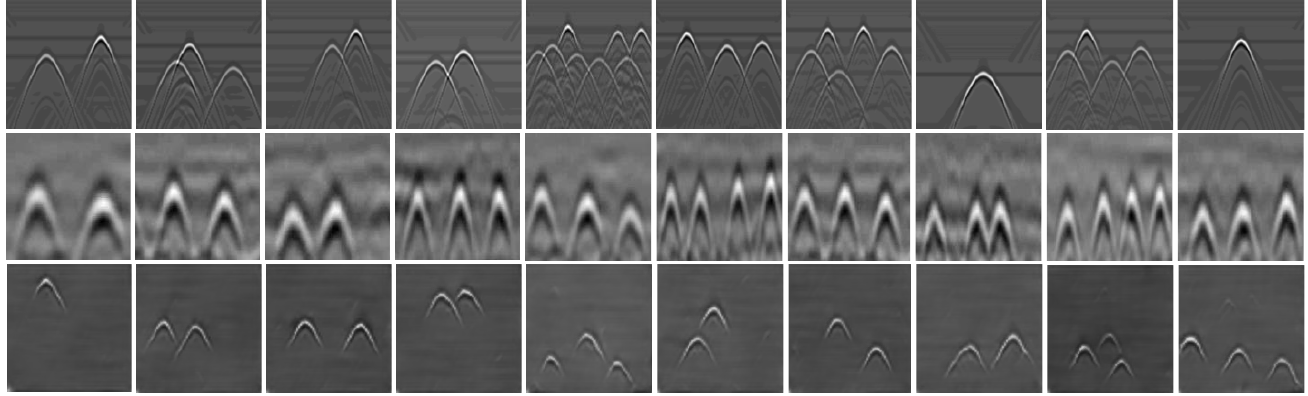
Figure 7. The 30 test images.